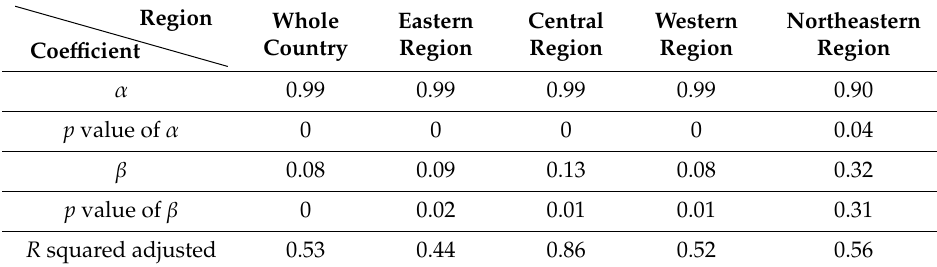
Table 4. Convergence test results of EFPE values in regions of China